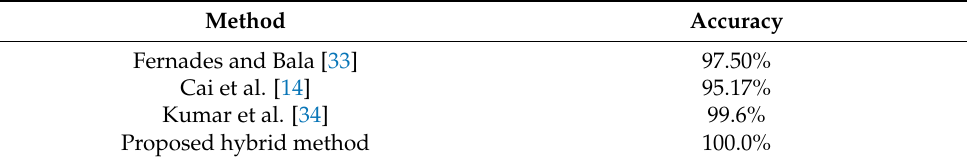
Table 8. Accuracy Analysis based on the Extended Yale-B dataset.